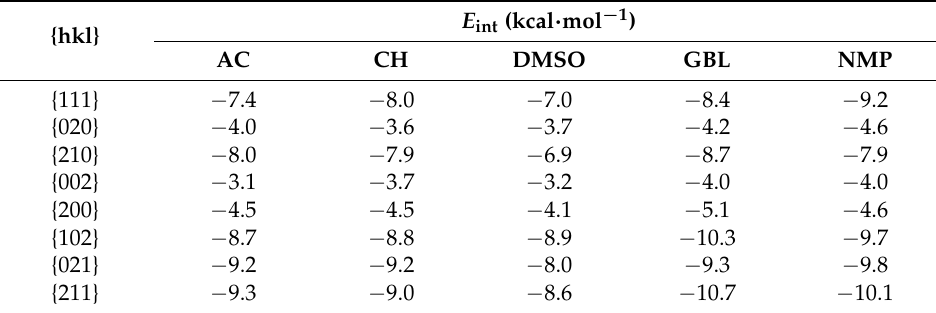
Table 2. The calculated E int between each RDX faces and solvent molecules.